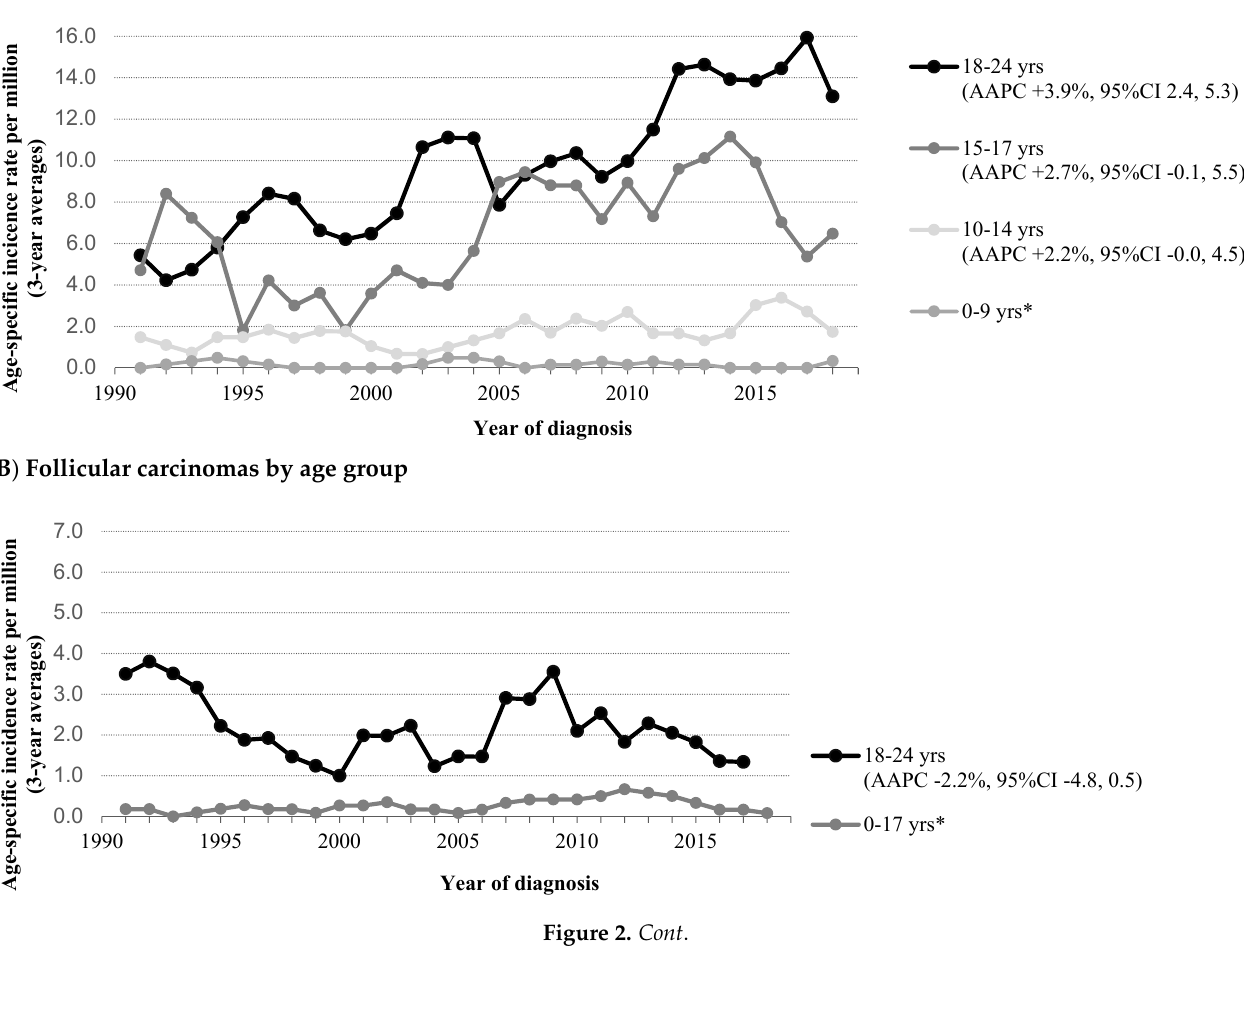
Figure 1. Time trends in incidence of patients aged 0–24 years with thyroid carcinoma in the Netherlands, 1990–2019. Abbreviations: AAPC, Average Annual Percent Change; CI, Confidence Interval. Three-year moving averages of the age-standardized incidence rate of thyroid carcinoma (standardized according to the World Standard Population) are shown. AAPC was estimated from a regression line, which was fitted to the natural logarithm of the rates using the year of diagnosis as a regressor variable.